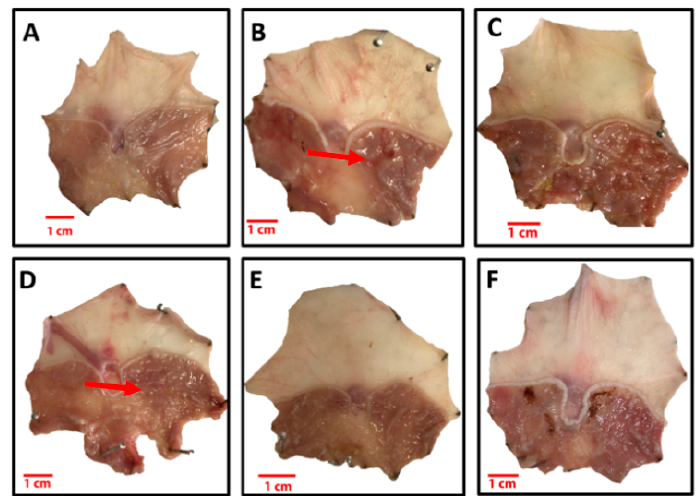
Figure 2. Gastric mucosa photographs of animals in the experimental groups ( A ) Negative control group, no observable alteration ( B ) Positive control group, slight-to-moderate degree of edema ( C ) Preventive treatment group with 0.5 g of glutamine per kilogram of weight, slight degree of edema ( D ) Preventive treatment group with 0.5 g of glutamine per kilogram of weight and 5 million CFU Lactobacillus reuteri No observable macroscopic alteration, slight degree of edema ( E ) Regenerative treatment group with 0.5 g of glutamine per kilogram of weight, slight degree of edema ( F ) Regenerative treatment group with 0.5 g of glutamine per kilogram of weight and 5 million CFU Lactobacillus reuteri, slight degree of edema.